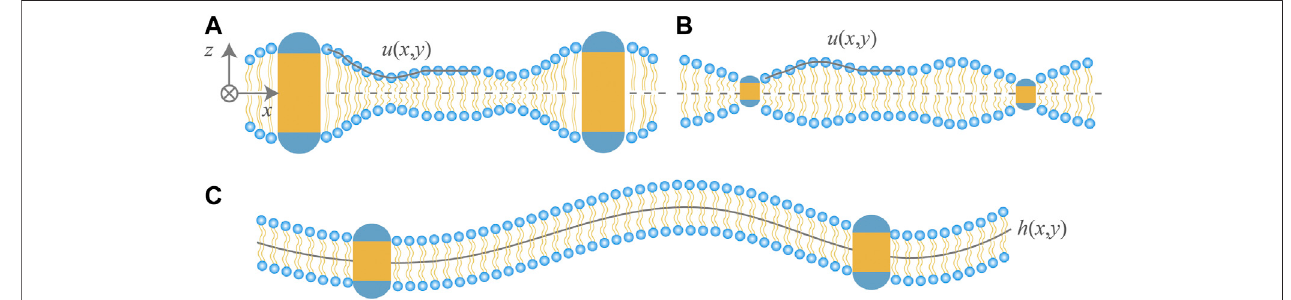
FIGURE 1 | Cartoon of lipid bilayers containing two rigid cylindrical proteins. Hydrophilic regions of the proteins are shown in blue and hydrophobic in yellow. Hydrophobic thickness of the proteins in (A , B) is, respectively, greater and less than that of the bilayer in the unperturbed state. For up-down symmetric bilayers, the thickness deformations due to hydrophobic mismatch are described by the pro fi le u ( x , y ) of the upper monolayer. The protein inclusions in (C) have the same hydrophobicthicknessasthebilayerand modifytheshape fl uctuationsofthebilayerascanbecharacterizedbythemidplane pro fi le h ( x , y ).Thebilayermidplane in (A , B) is drawn to be horizontal for simplicity, since thickness deformations decouple from midplane